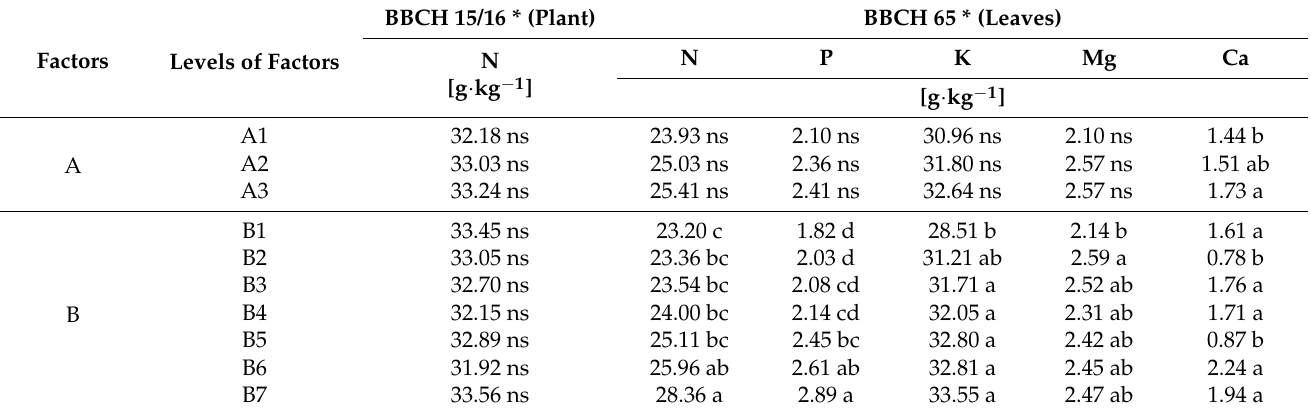
Table 8. Average values of macronutrient content in plant and leaf dry matter for cultivars (A) and fertilizer (B).